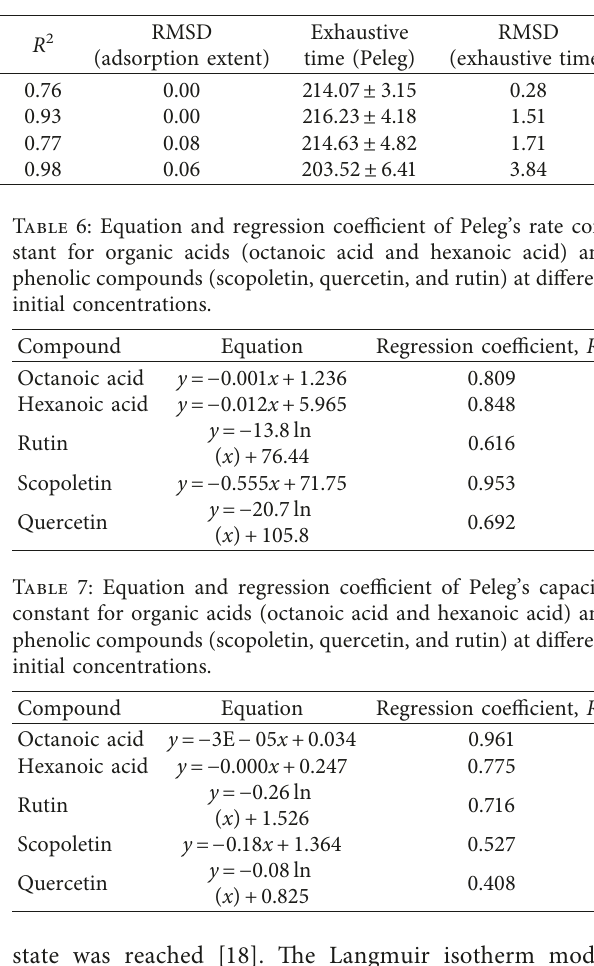
and K ) for adsorption of quercetin with regression coefficient ( R 2 ), and the root 1 2